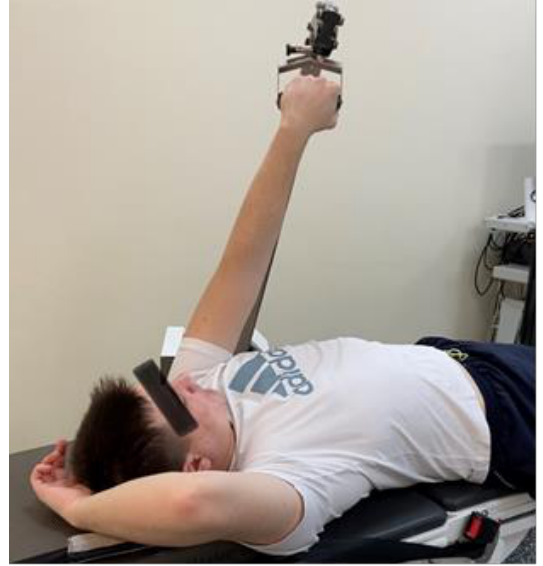
Figure 2. Flexion-extension with simultaneous rotation during robotic mechanotherapy on CON-TREX